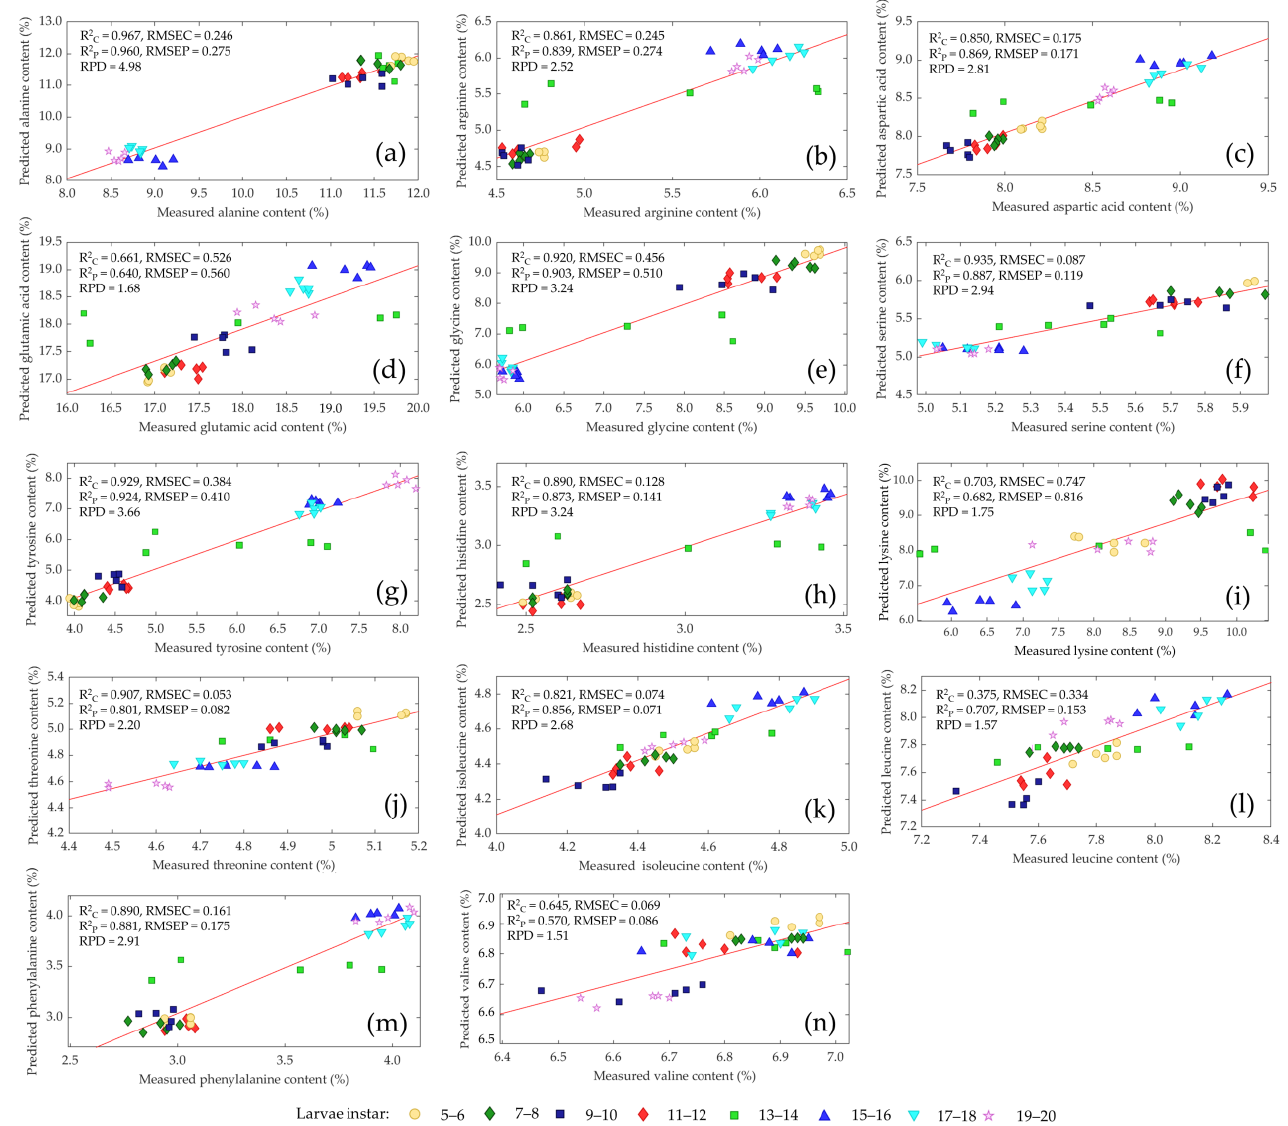
Figure 4. Comparison of measured and predicted values of alanine ( a ), arginine ( b ), aspartic acid ( c ), glutamic acid ( d ), glycine ( e ), serine ( f ), tyrosine, ( g ), histidine ( h ), lysine ( i ), threonine ( j ), isoleucine ( k ), leucine ( l ), phenylalanine ( m ) and valine ( n ) of living mealworm larvae with different larvae instars ( • 5 – 6, 7 – 8, ◼ 9 – 10, 11 – 12, ◼ 13 – 14, 15 – 16, 17 – 18, 19 – 20) in validation sets using near-infrared spectroscopy.